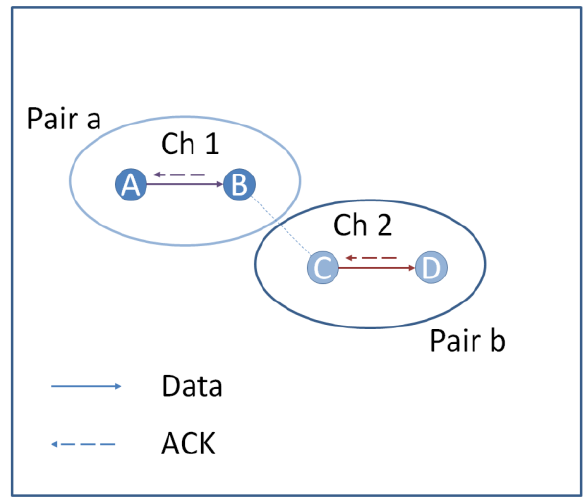
Figure 4. Two pairs of nodes using different communication